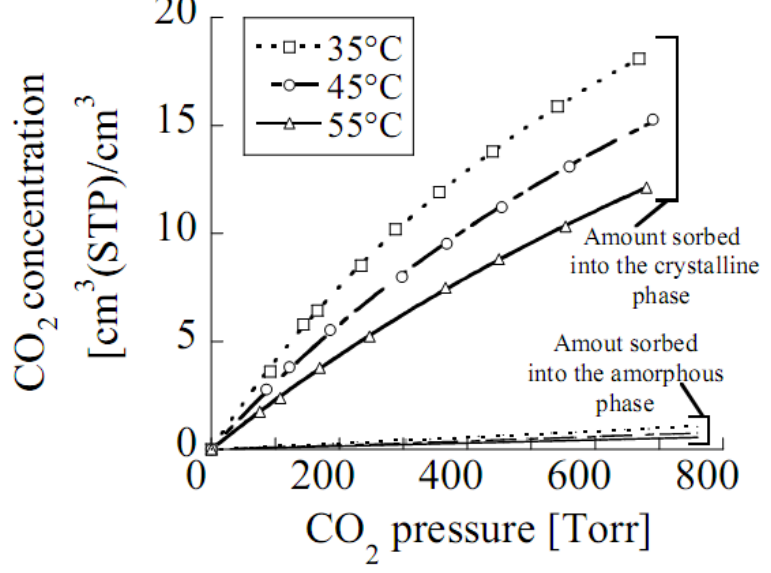
Figure 6. Sorption isotherms of carbon dioxide in the crystalline phase (upper curves) and in amorphous phase (lower curves) of s-PS δ form at several temperatures. Lines represent fitting by Langmuir isotherm (crystalline phase) and Non-Equilibrium Lattice Fluid model for the amorphous phase [83]. Data taken from reference